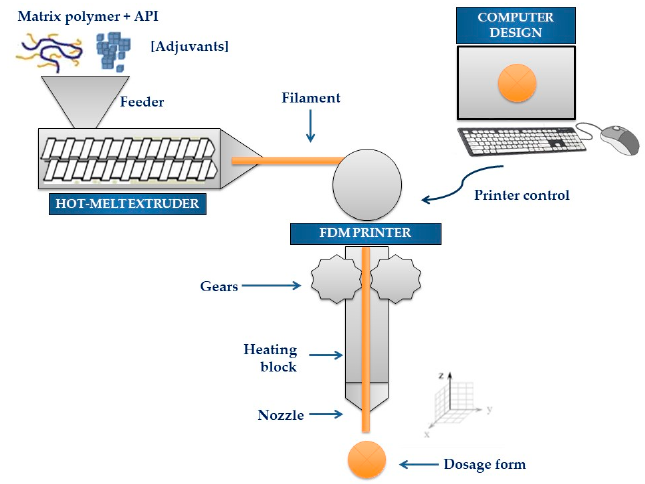
Figure 3. Schematic representation of integrated hot-melt extrusion and fused deposition modelling for pharmaceutical applications.